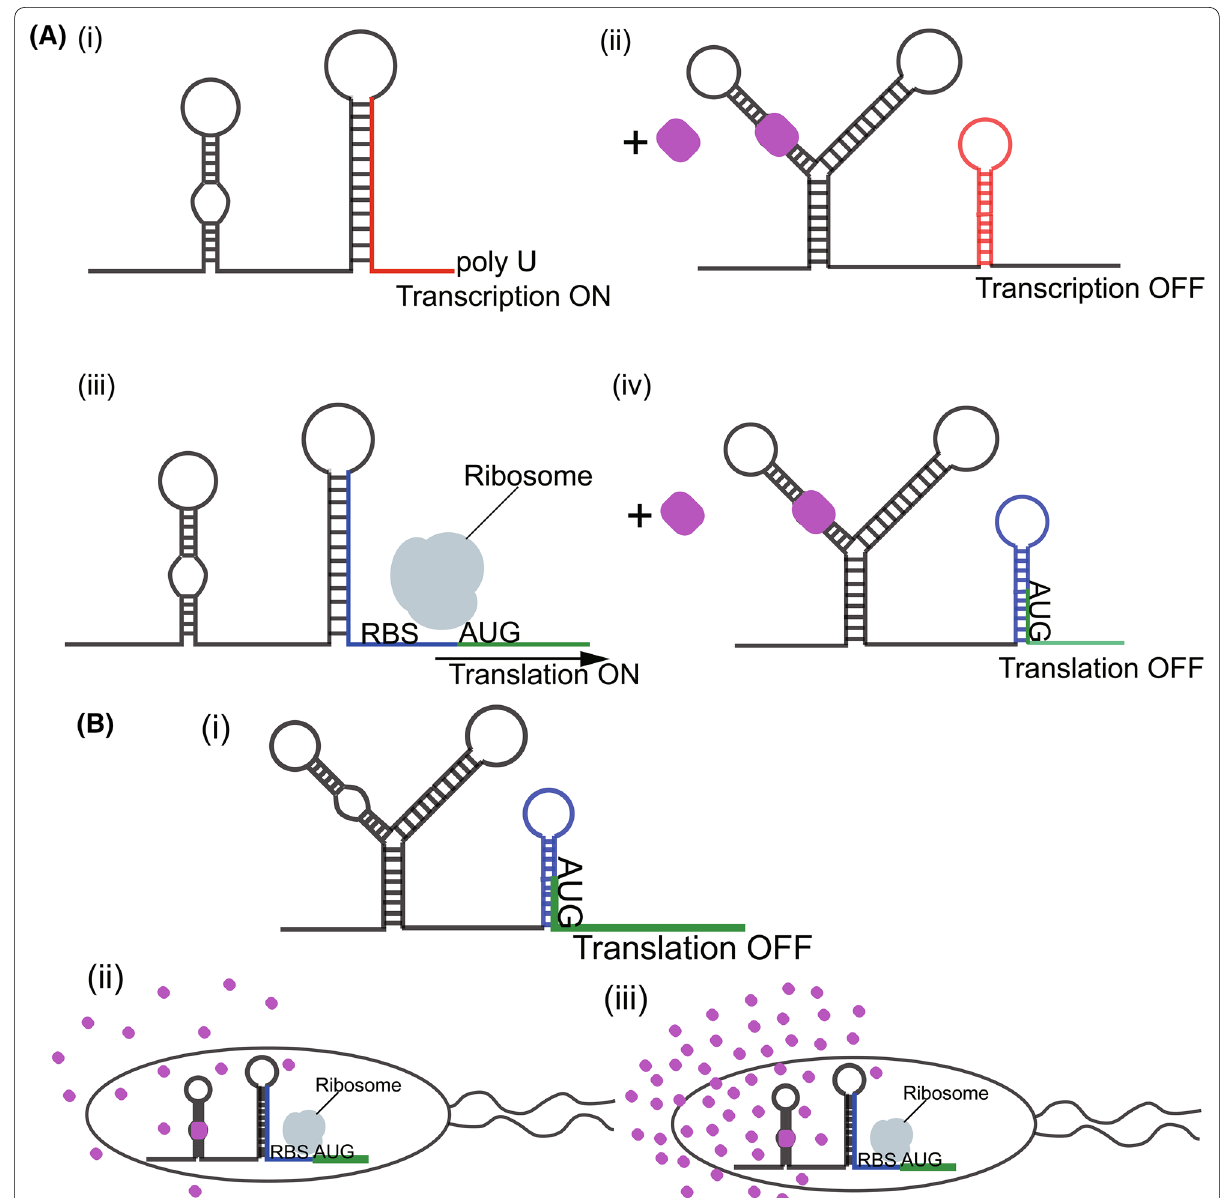
Fig. 6 Mechanism of action of riboswitches. A (i, ii) Binding of ligand to a riboswitch triggers the formation of a hairpin loop that terminates transcription. A (iii, iv) Binding of ligand to a riboswitch generates the formation of a helix that sequesters the RBS to inhibit the translational process. B (i, ii, iii) Application of riboswitches as biosensors. Riboswitches can be linked to colorimetric reporters (for example GFP) to screen for high‑producing strains depending on the concentration of the compound of interest. There is a high expression of the reporter gene when the concentration of a ligand is high (B ii) and vice